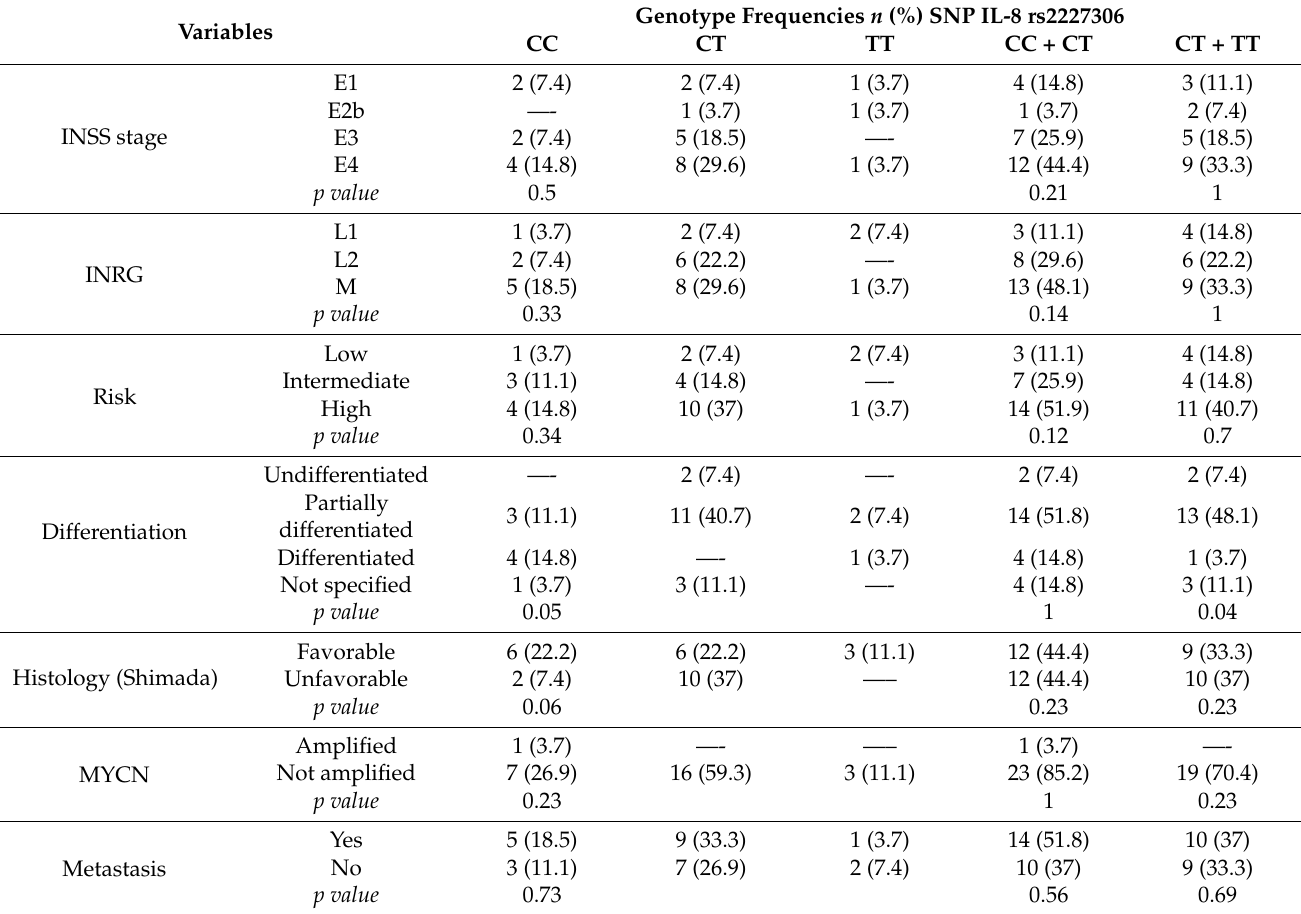
Table 5. Genotype frequencies of the gene IL-8 +781 C/T rs2227306 and prognostic factors of NB